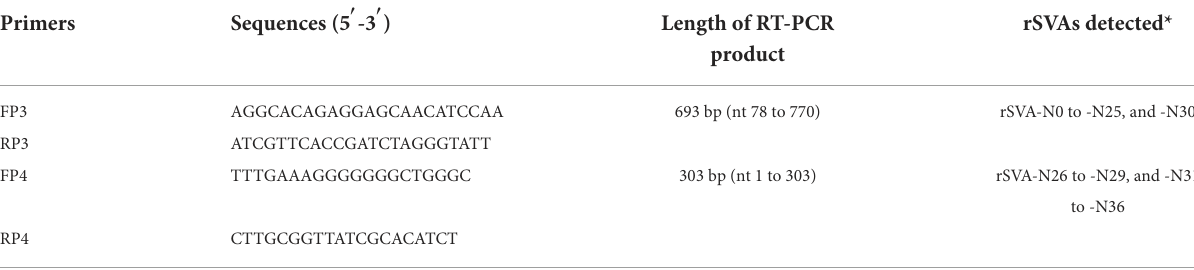
TABLE 2 Two pairs of primers for RT-PCR analysis of